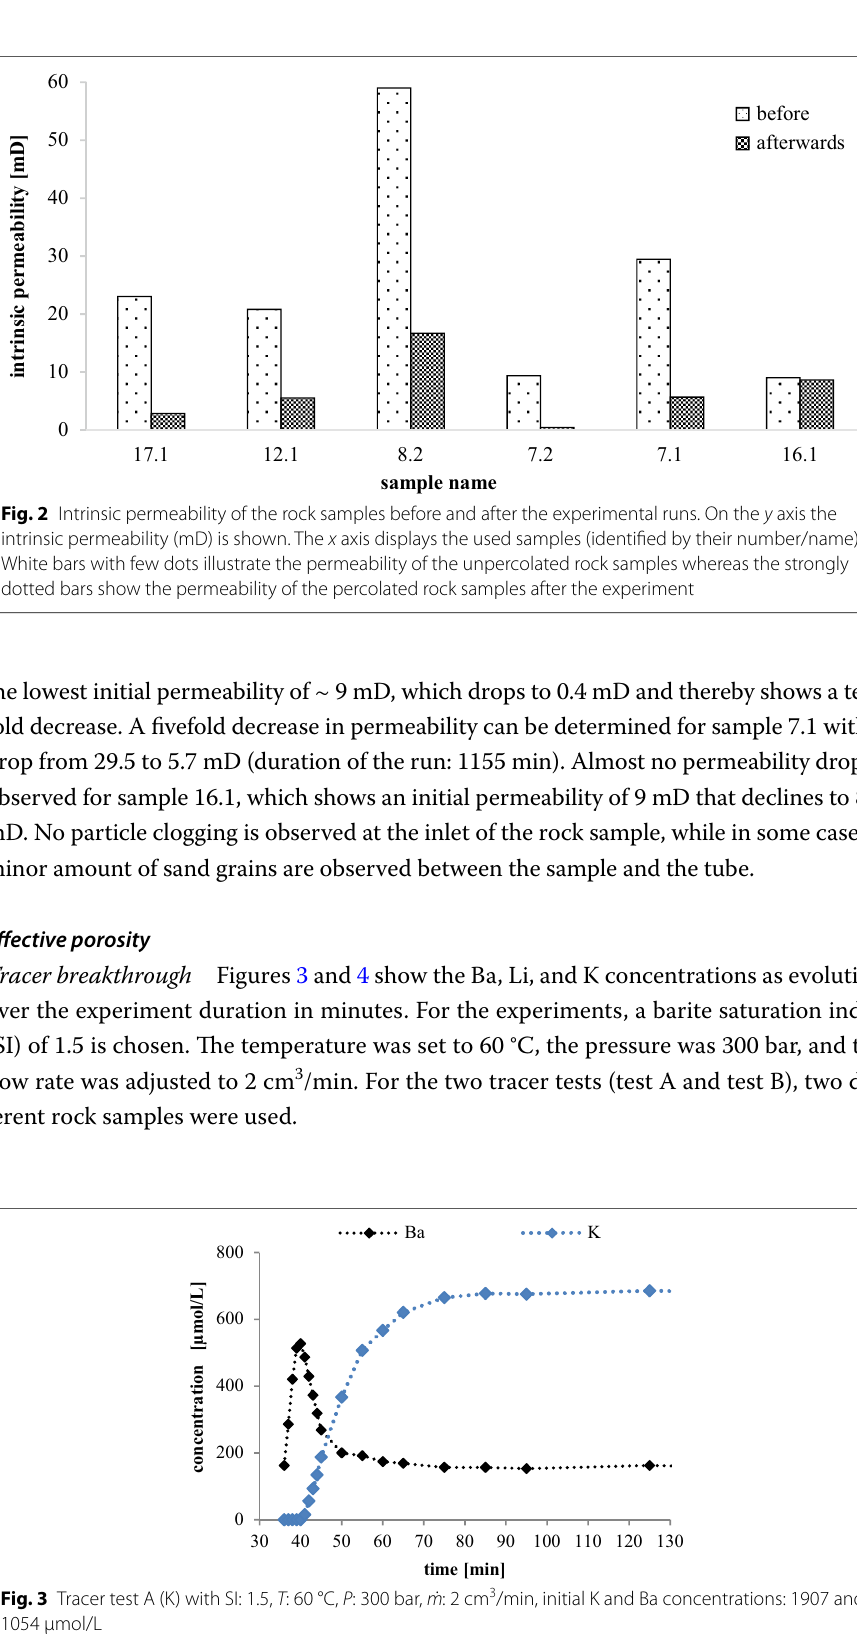
Fig. 3 Tracer test A (K) with SI: 1.5, T : 60 °C, P : 300 bar, 1054